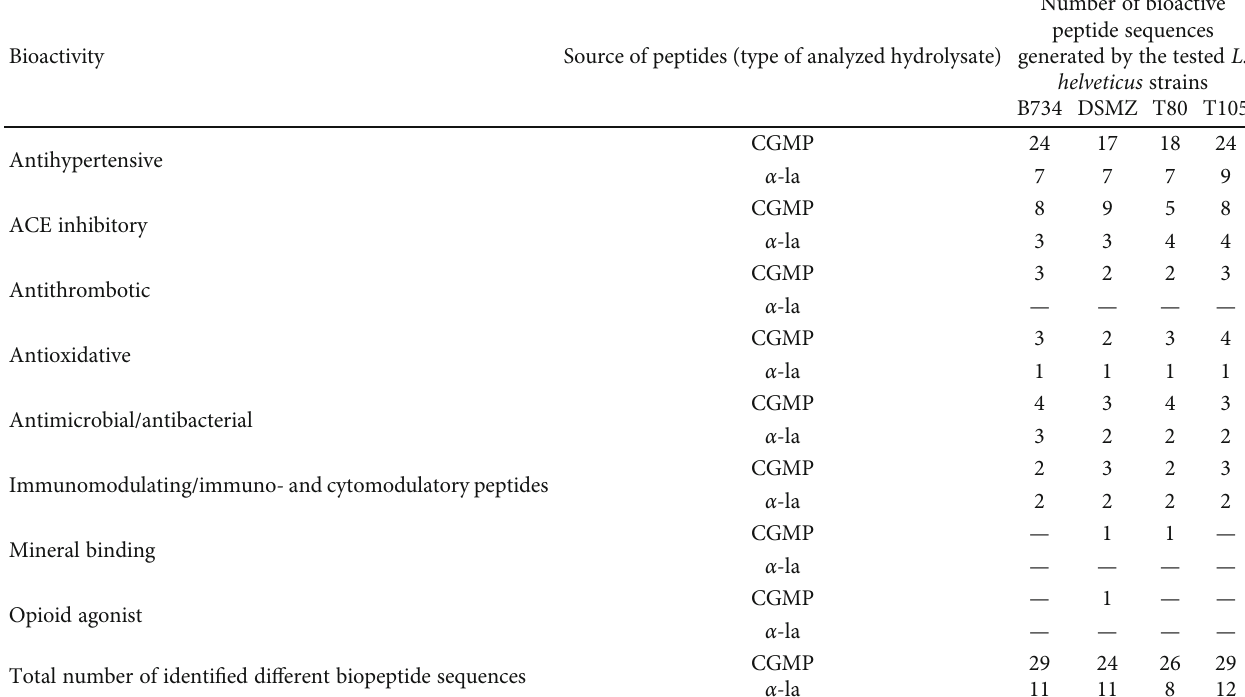
Table 2: Number of detected biopeptide sequences (with identi fi ed bioactivity) generated from the tested protein preparations by the analyzed L. helveticus strains.